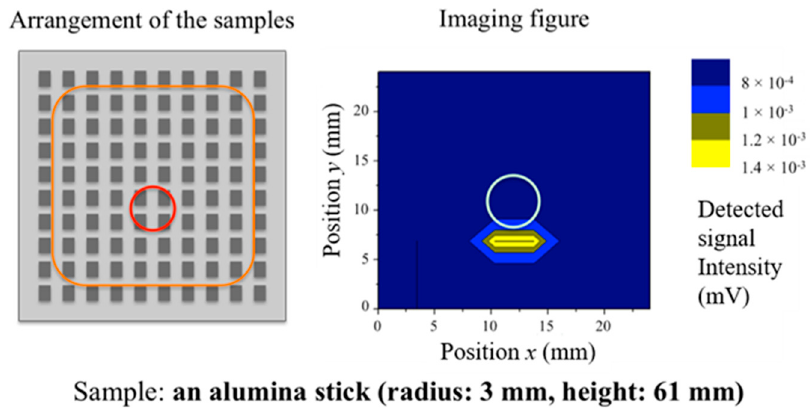
Electronics 2019 , 8 , x FOR PEER REVIEW Figure 16. The two-dimensional imaging of dielectric samples (an alumina stick).